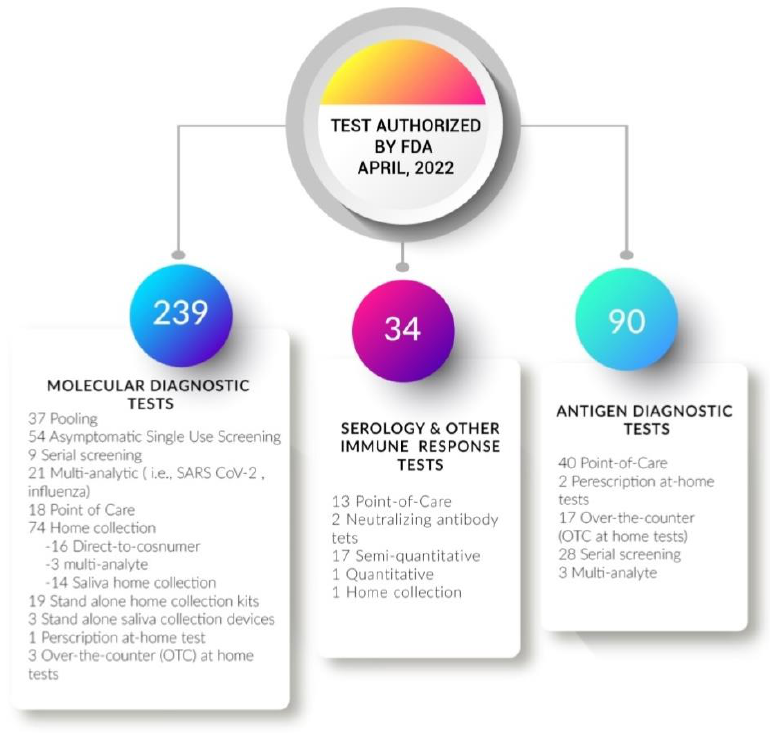
(Figure 6) [80]. The advanced diagnostics of SARS-CoV-19 in development are represented